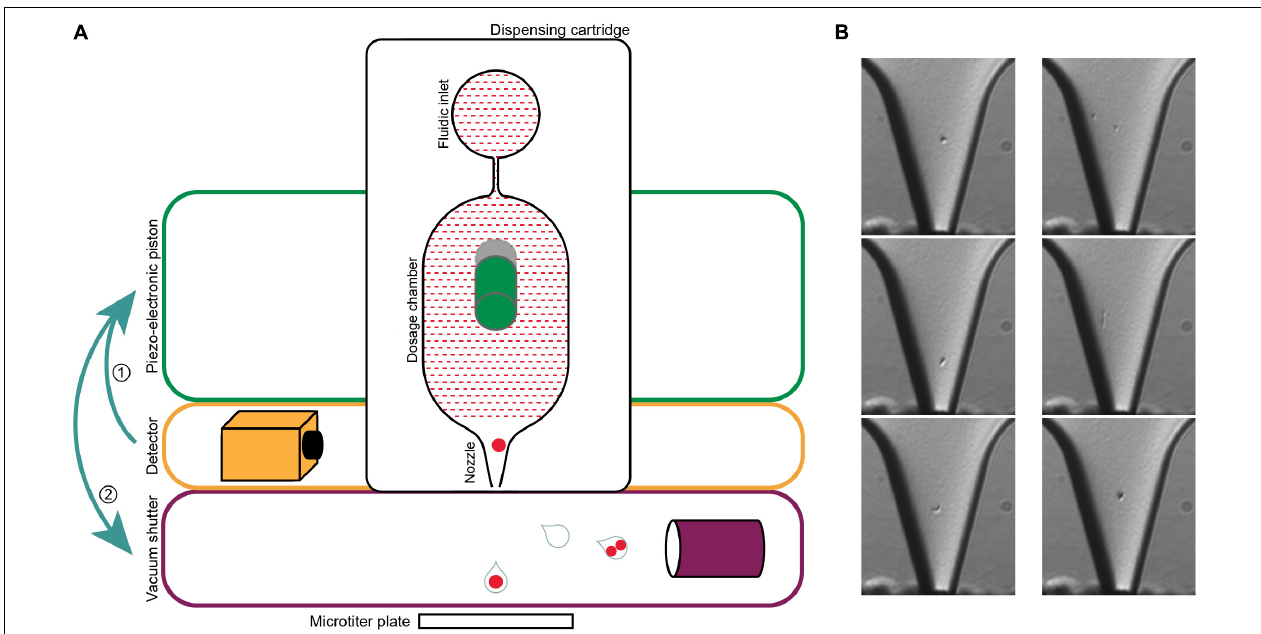
FIGURE 2 | Single-cell printer and single cell micrographs. (A) Schematics of the single-cell printer. Upon detection of cells in the nozzle of the dispensing cartridge, the piezo-electronic piston deflects the back of the dosing chamber. The displacement of the liquid suspension inside the chip (red shaded area) enforces the release of a droplet that is then either captured in a microtiter plate (single cell) or removed by vacuum suction (all other cases). Adapted from Gross et al. (2013). (B) Micrographs of single cells (left panel) and two cells (right panel) in the nozzle. The images are recorded at the time of detection, thereby allowing the linkage of every micrograph to the corresponding micro-well. The occurrence of two cells in one drop might either be two independent cells (top), a cell in a late stage of division (middle) or two attached cells that might be of different origin (bottom). Scale bar is 10 µ